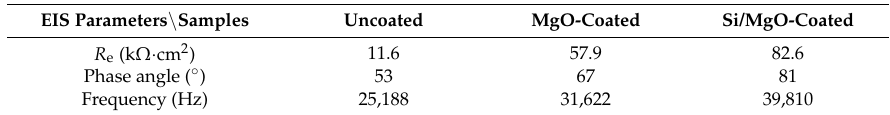
Table 2. Fitted electrochemical impedance spectroscopy (EIS) results of uncoated, MgO-coated and Si/MgO-coated in simulated body fluid (SBF) solution. EIS Parameters\Samples Uncoated MgO ‐ Coated Si/MgO ‐ Coated R